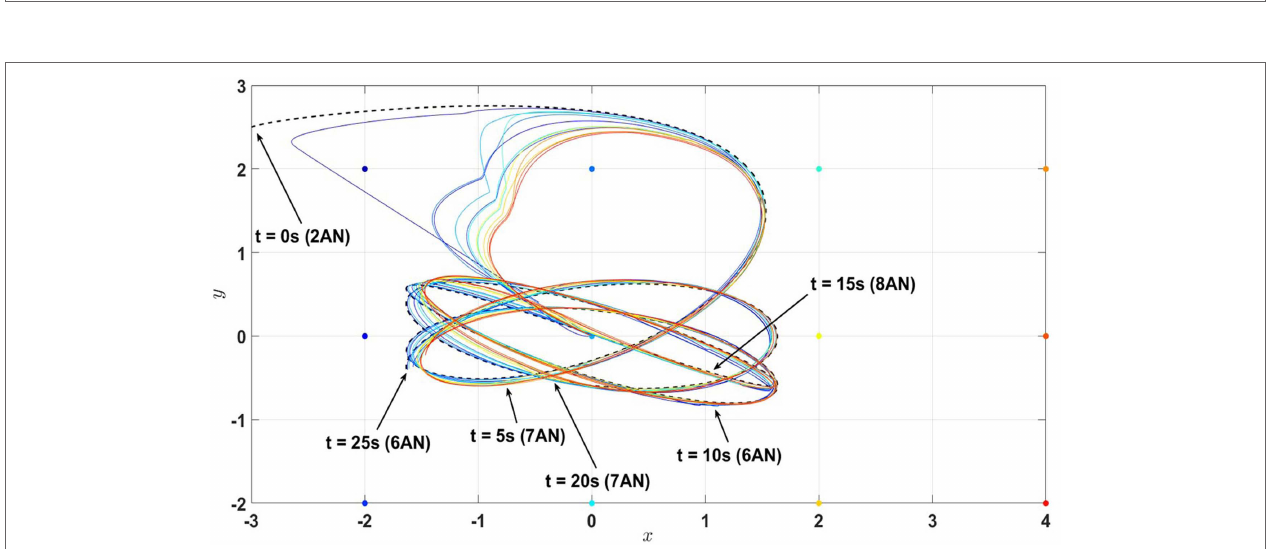
FIGURE 14 | Position estimates (first and third states of the process) of the active-passive sensor network in Example 4 with 12 nodes under the proposed architecture equations (58) and (59) and satisfying the linear matrix inequalities equations (60) and (61) (the dash line denote the trajectory of the actual process (i.e., the combination of the first and third states) and the solid lines denote the state estimates of nodes). Here, AN stands for the active nodes.